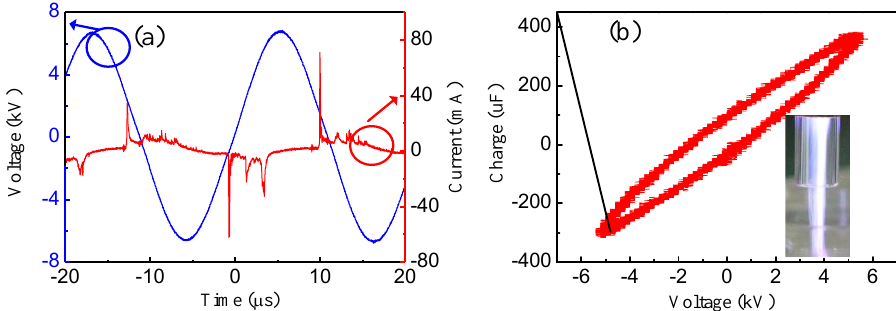
Figure 2. ( a ) Voltage and current discharge waveforms and ( b ) the corresponding Lissajous figure (The inset shows discharge image of A-Jet).